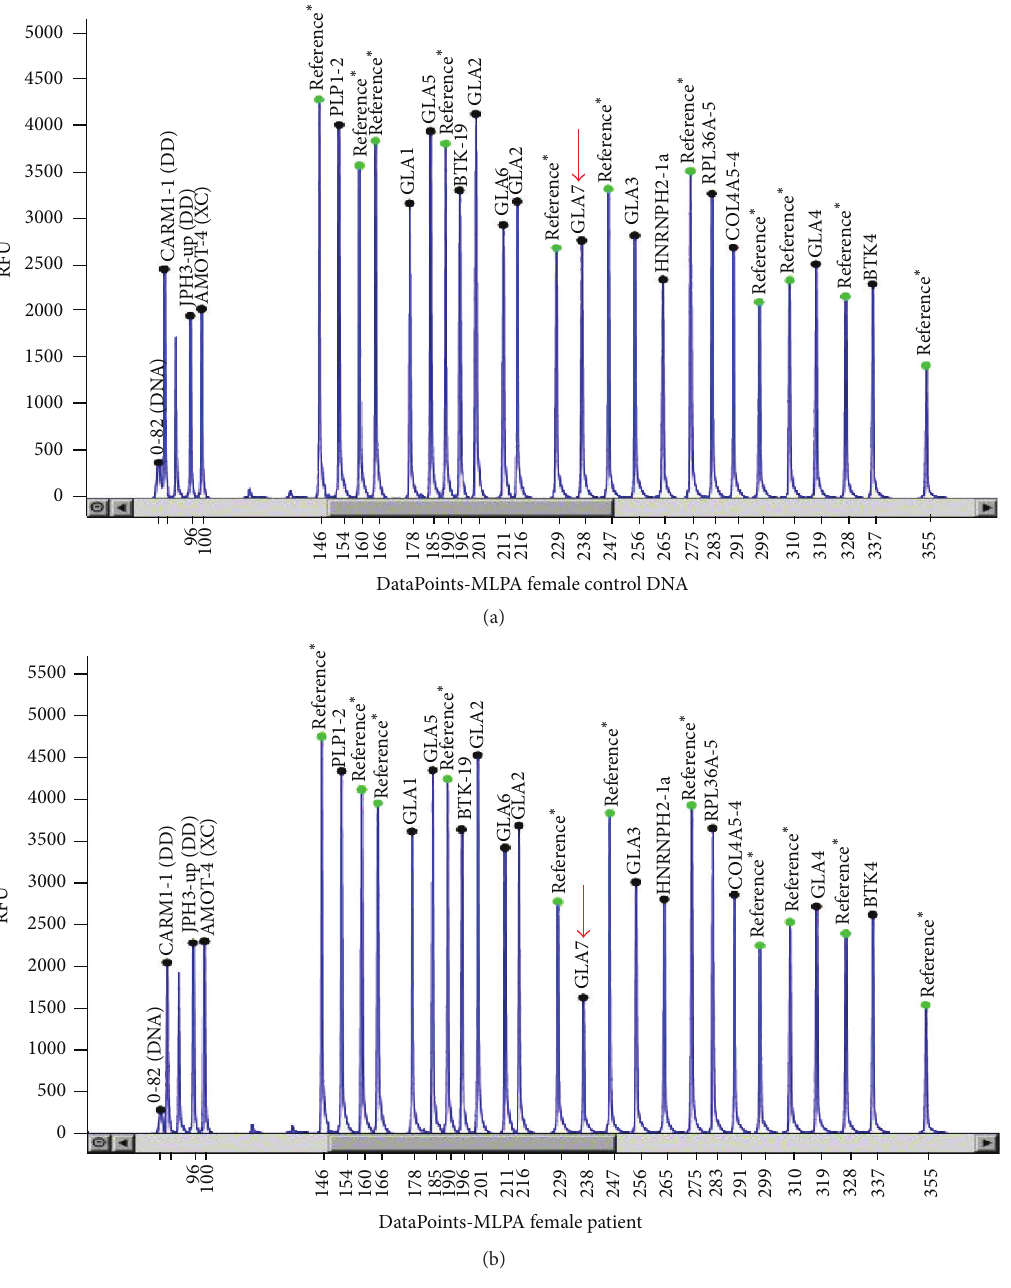
Figure1:MultiplexLigation-dependentProbeAmplification(MLPA)electropherogramtracings.(a)Normalfemalecontroland(b)proband. The arrow indicates the deleted exon 7. ∗ Reference